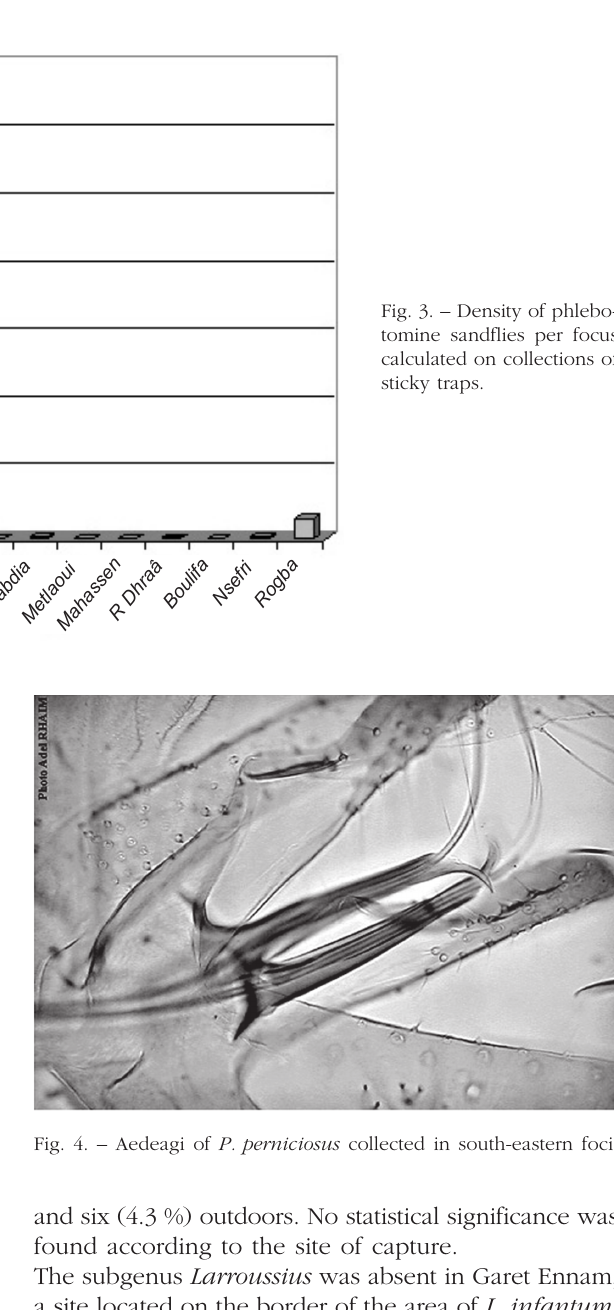
and six (4.3 %) outdoors. No statistical significance was found according to the site of